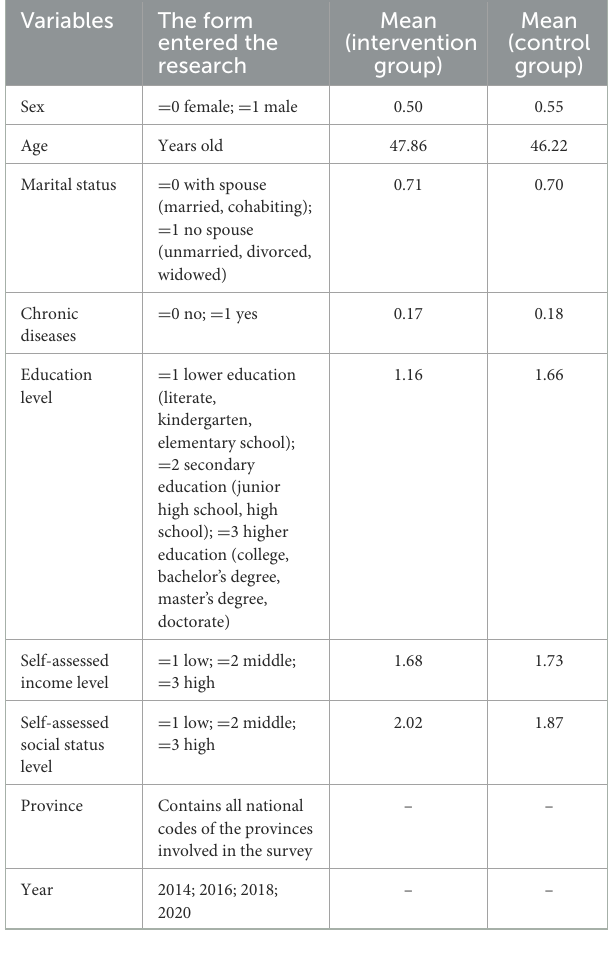
TABLE 1 Definition and assignment of rules regarding independent